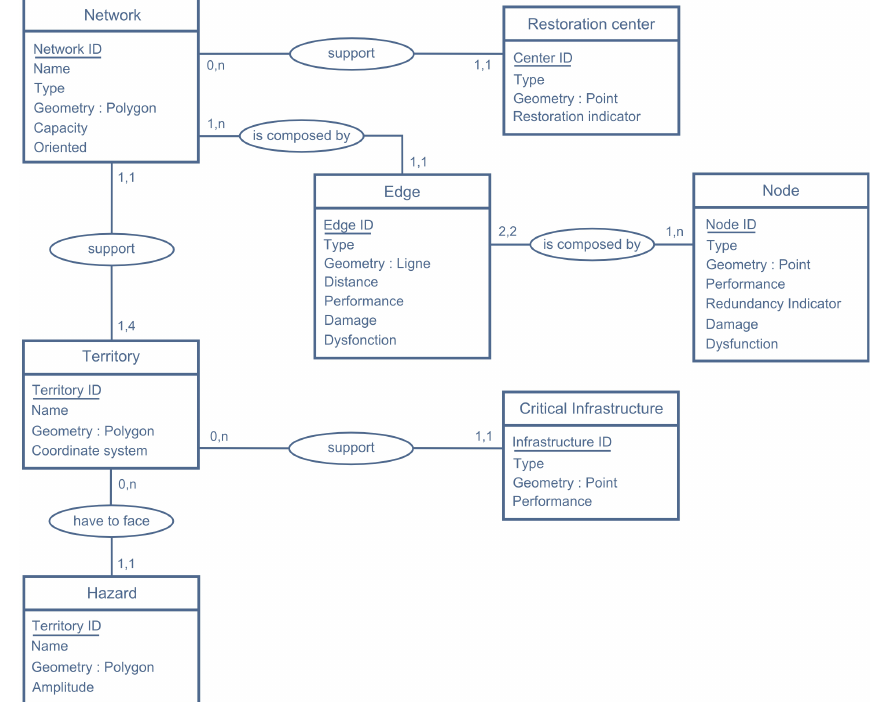
Fig. 2. Entity-relationship model for the Web-GIS